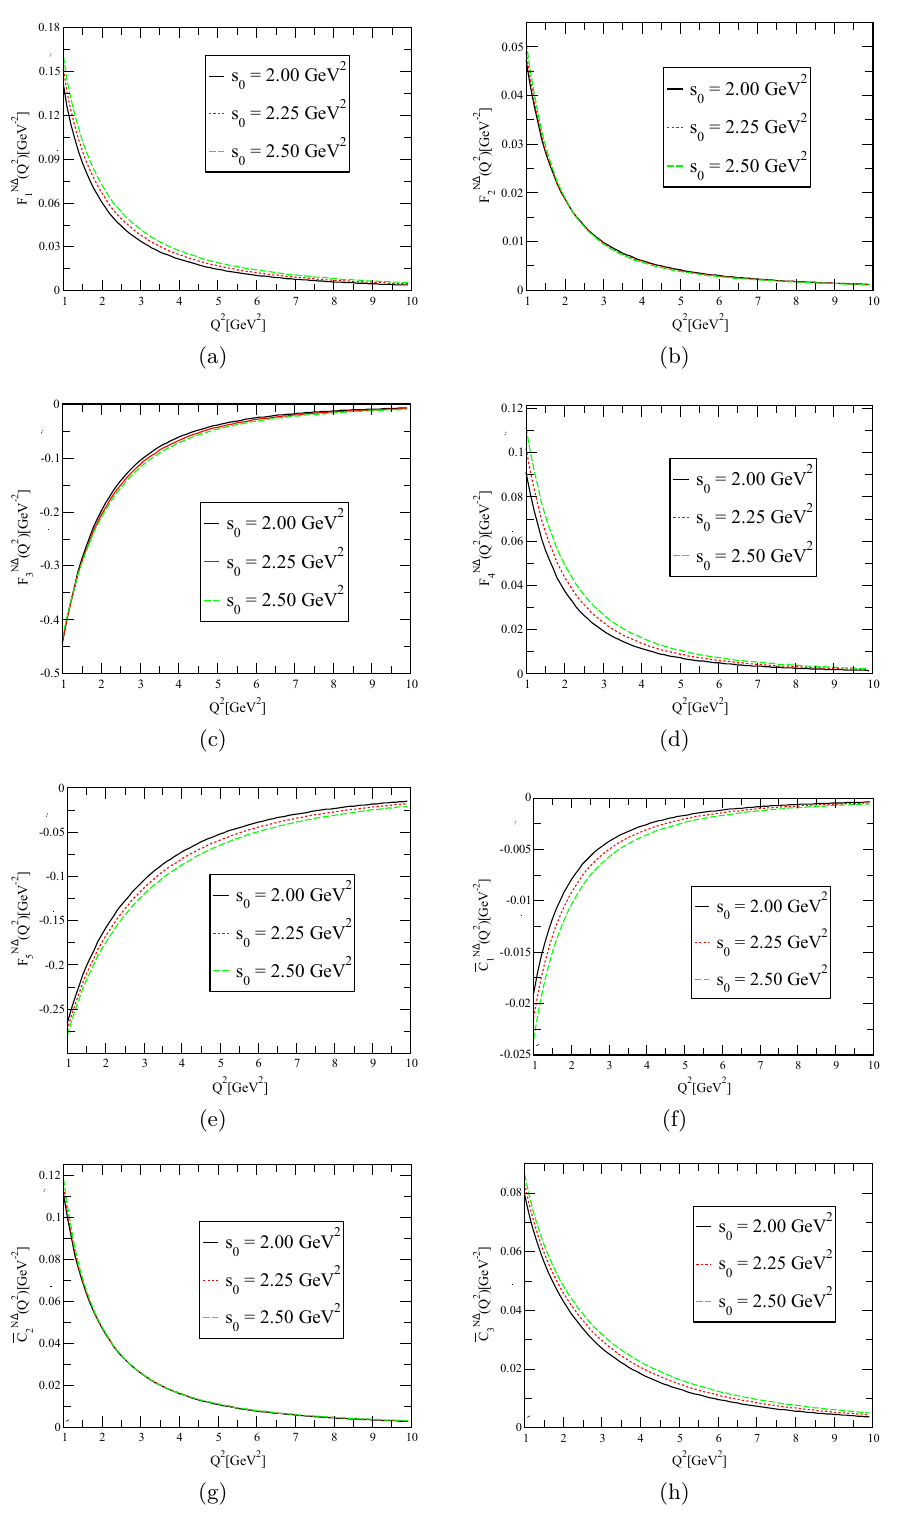
Figure 3 . The dependence of the N → ∆ transition GFFs on Q 2 at fixed values of the s 0 , average M 2 and set-I